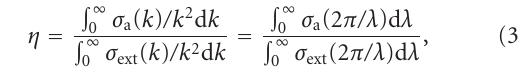
C ) − L/ (1 + 0 L 2 R / ( R 2 L 2 ), and R + ω 2 1 0 1 0 a in the idealized dipole 0